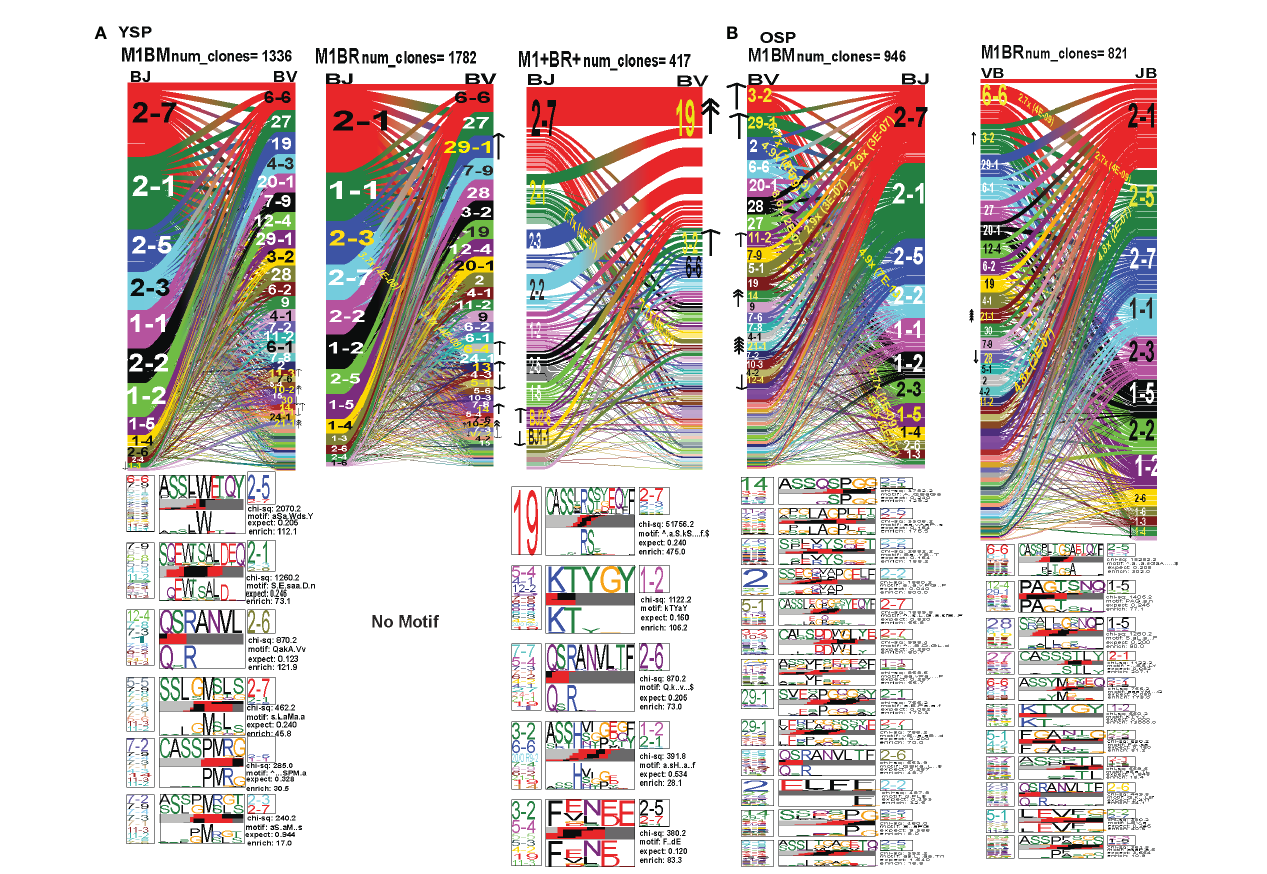
FIGURE 9 The hierarchy of BV and BJ gene pairing and CDR3 motifs of cross-reactive M1BM, M1BR, and M1+BR+ CD8 T cell populations differ from cognate and between young (A) and older donors (B) . This was determined after TCR high throughput sequencing of tetramer-sorted CD8 T cells in Y and O donors (Y, n=4; O, n=4-5) using ribbon-plot analyses (6, 8). The fi gure legends of Figures 6, 7, provide a detailed description of the ribbon-plot analyses that is applicable to this fi gure. M1BM or M1BR are cross-reactive EBV-BM or EBV-BR tetramer+ cells sorted from IAV-M1 stimulated short term cultures. M1 +BR+ are double tetramer+ co-staining CD8 T cells sorted from the IAV-M1 short-term